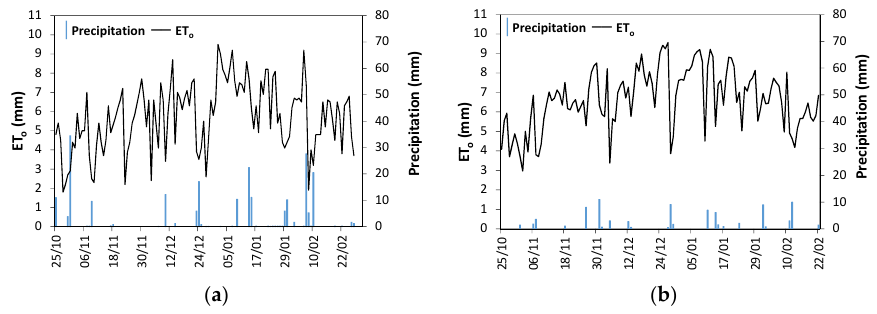
Figure 6. Daily precipitation and reference evapotranspiration (ET o ) during the maize crop seasons for: ( a ) dry years; and ( b ) very dry years.